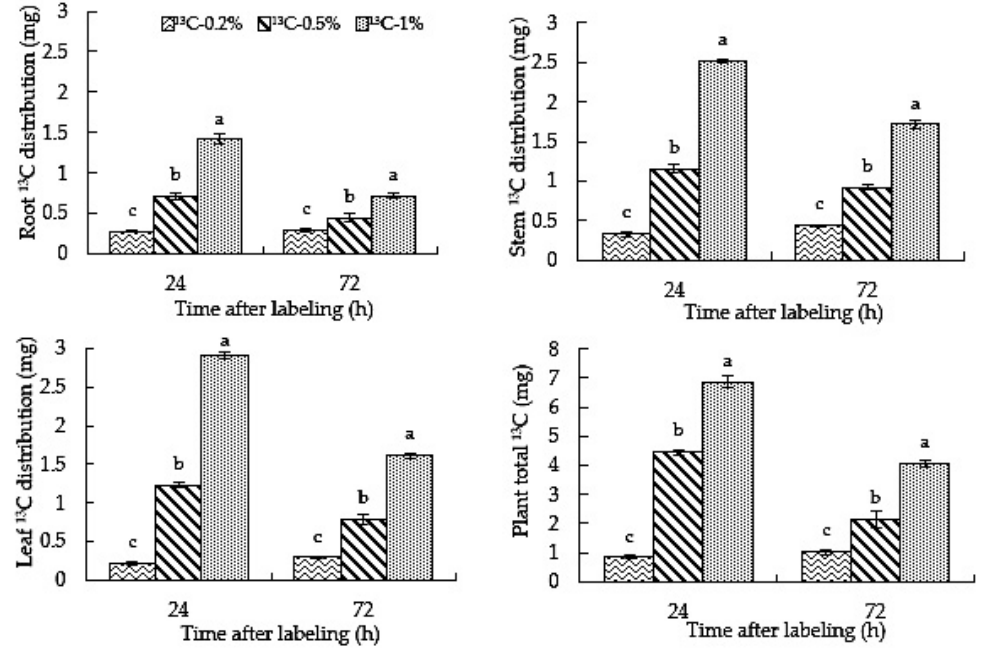
Figure 3. High root-zone 13 CO 2 affects the distribution of C in roots, stems and leaves of oriental melons. Standard errors (SEs) of the means are represented by error bars. Different letters in the same row indicate significance at the 0.05 level among treatments.